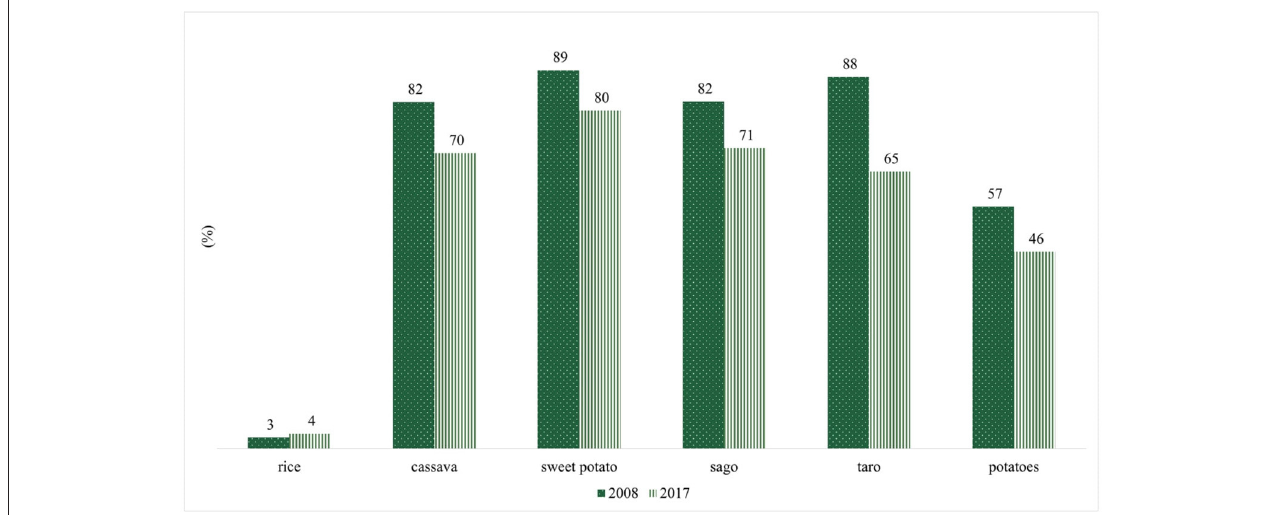
FIGURE 4 | The proportion of rice and other tubers consumed from own production to total consumption in 2008 and